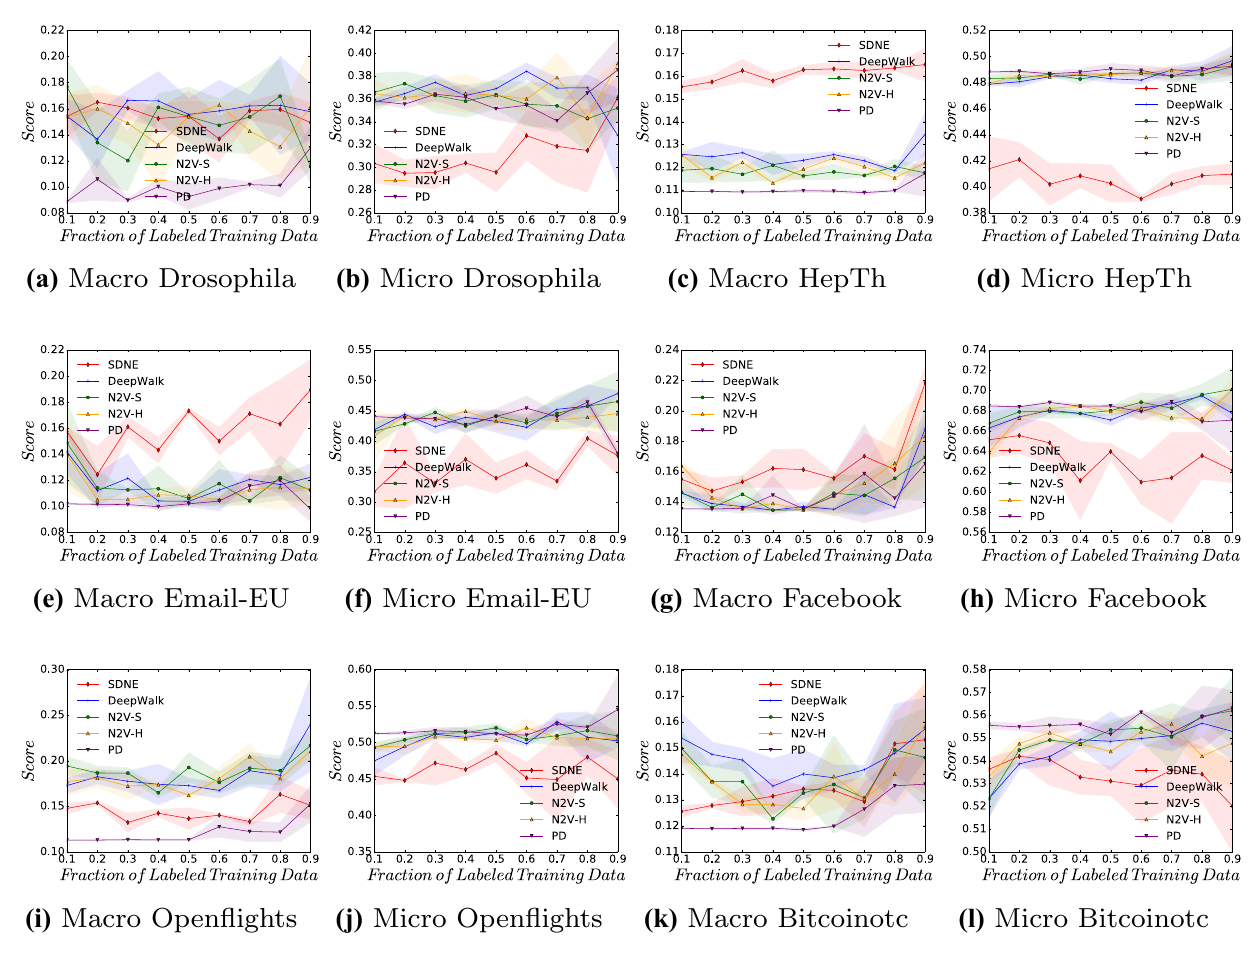
Fig. 5 Micro-f1 and macro-f1 scores, across a range of labelling fractions, for all approaches when predicting a vertex’s local clustering coef- ficient (CLU) value across all